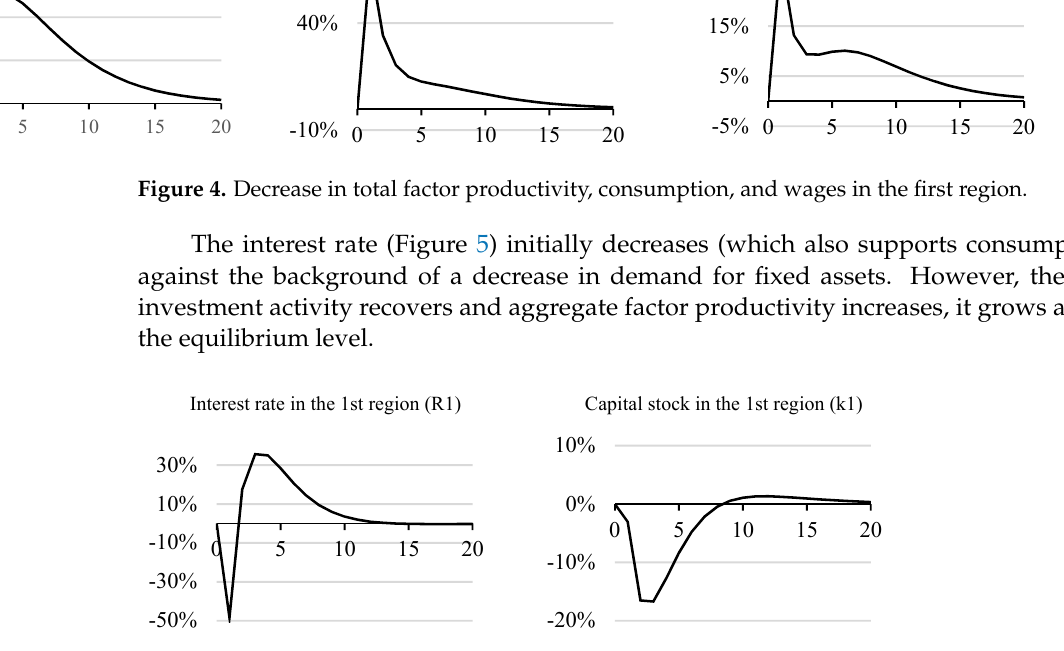
Figure 5. Interest rate fluctuations and loss of fixed assets in the first region.